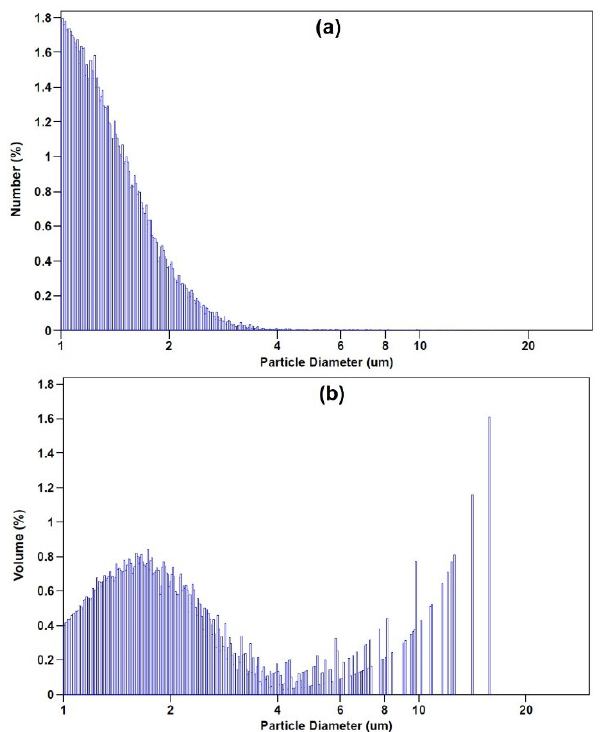
Figure 3. ( a ) SEM image of the Si sludge, ( b ) and ( c ) energy dispersive X-ray spectrometry (EDS) spectra for points 1 and 2, respectively.